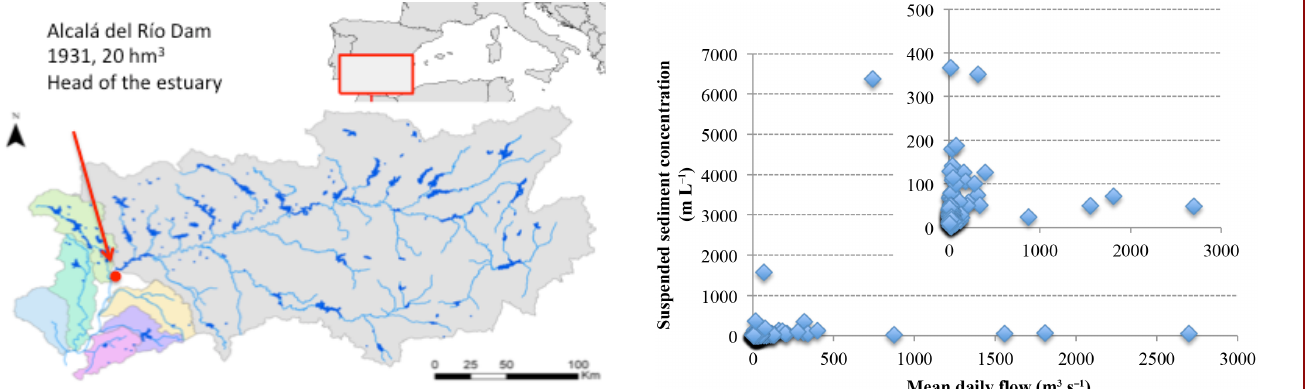
Figure 4. Rating curve water flow-suspended sediment concentra- tion downstream the Alcalá del Río Dam (Fig. 3) in the head of the Guadalquivir Estuary, obtained from data during 1993–2007; a zoom for the interval 0–500mgL − 1 is included for